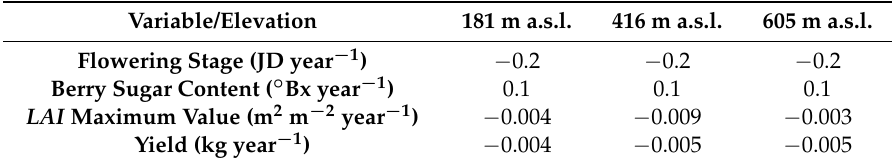
Table 5. Linear regression slopes evaluated for the variables discussed in the text over the whole 60-year period, 1950–2009, in three grid points with the same soil texture and different elevations.